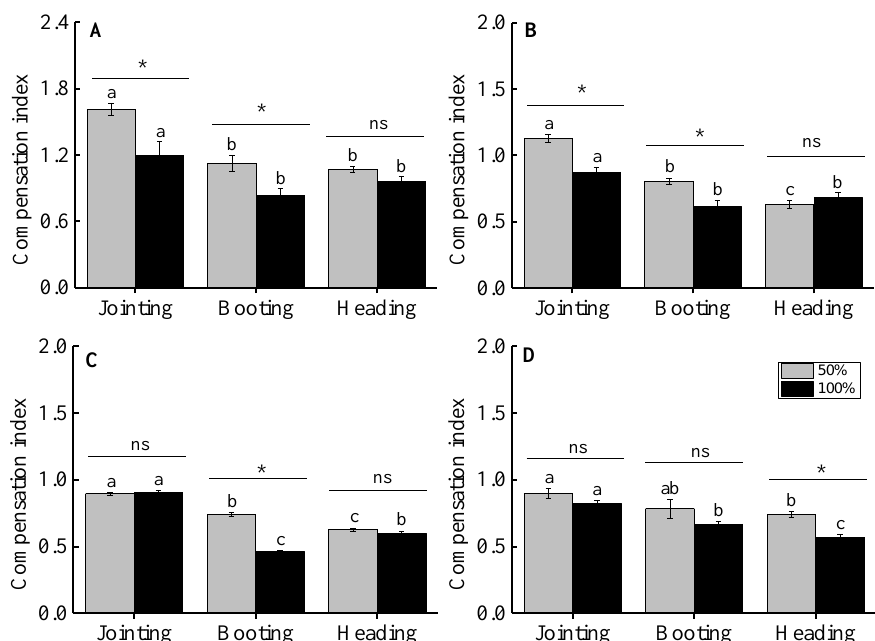
Figure 6. The effects of clipping intensity and phenological period on the compensation index of H. brevisubulatum at different grades. A, B, C, and D represent the grades (1, 2, 3, and 4, respectively) of the tuft diameters of H. brevisubulatum . Different lowercase letters represent significant differences among different phenological periods ( p < 0.05). *, ns represent that there was a significant difference ( p < 0.05) and no significant difference ( p > 0.05) between 50% and 100% clipping intensities, respectively.